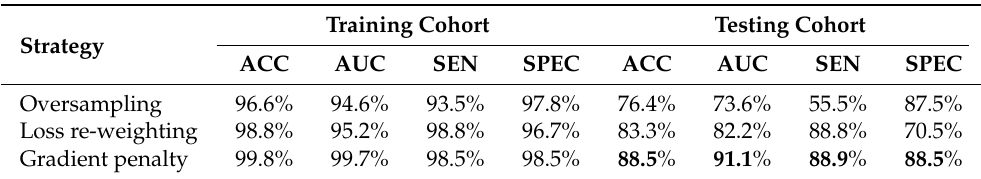
Table 3. Performance comparison of different strategies. Oversampling is the benchmark strategy. Both loss re-weighting and gradient penalty are based on oversampling, and gradient penalty is the strategy proposed in this